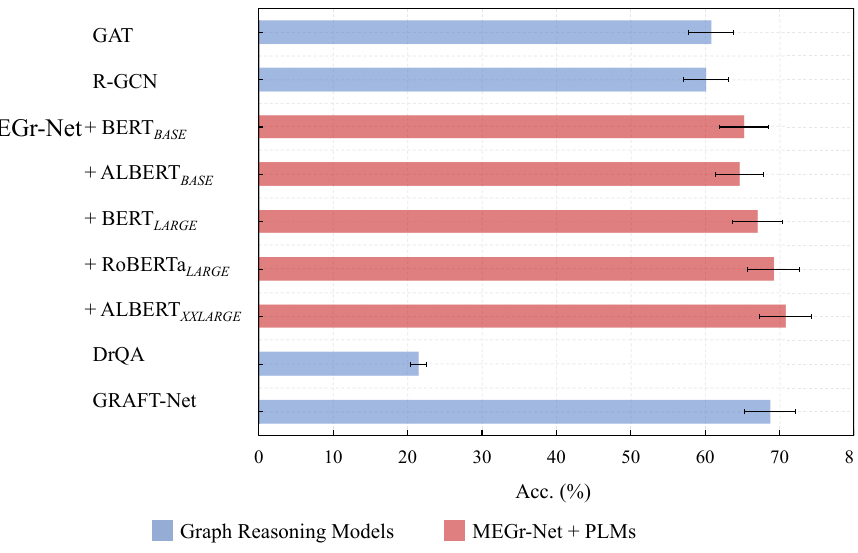
Figure 5. Results of graph reasoning models and PLMs in